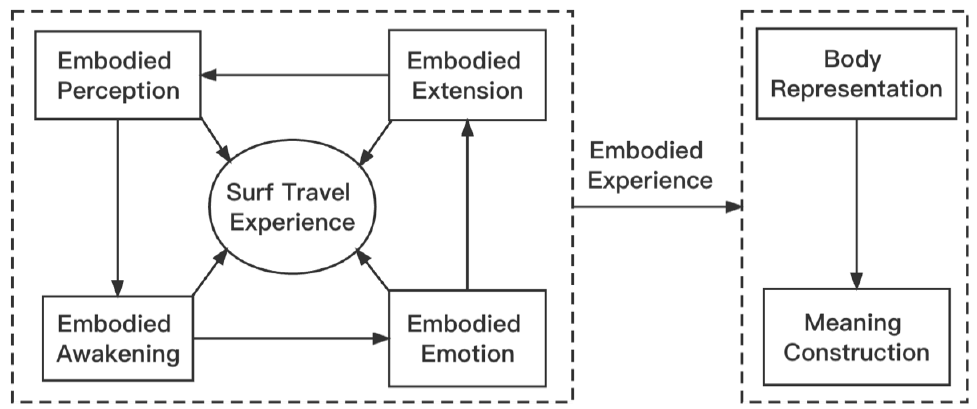
Figure 1. Typical relational structure of the main category.